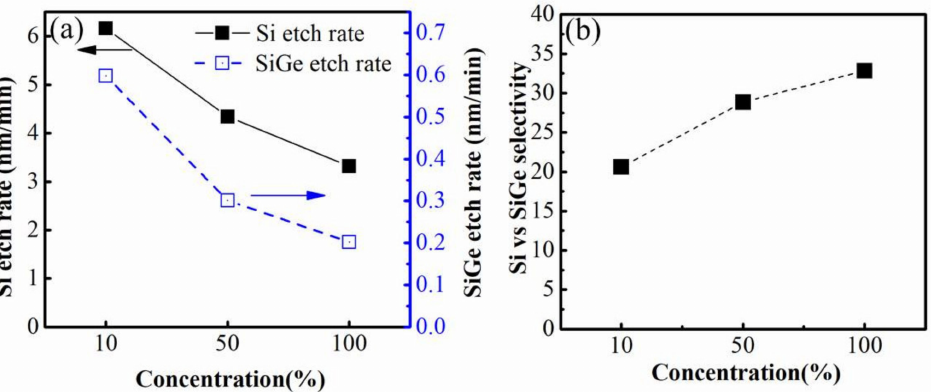
Figure 4. ( a ) The lateral etching rate of Si and the vertical etching rate of Si 0.7 Ge 0.3 , ( b ) the etching selectivity of Si to Si 0.7 Ge 0.3 under different concentration of ACT@ SG-201 at 40 ◦ C. Moreover, the selective etching profile of two periods Si 0.7 Ge 0.3 /Si multilayer by using the optimal ACT@SG-201 at 40 ◦ C is presented in Figure 5. The Si 0.7 Ge 0.3 layers extremities are “rectangular” without significant Si 0.7 Ge 0.3 loss after etching for 10 min at 40 ◦ C due to its high selectivity. This result further confirms that ACT@SG-201 without any dilution at the temperature of 40 ◦ C is the optimal condition due to its high